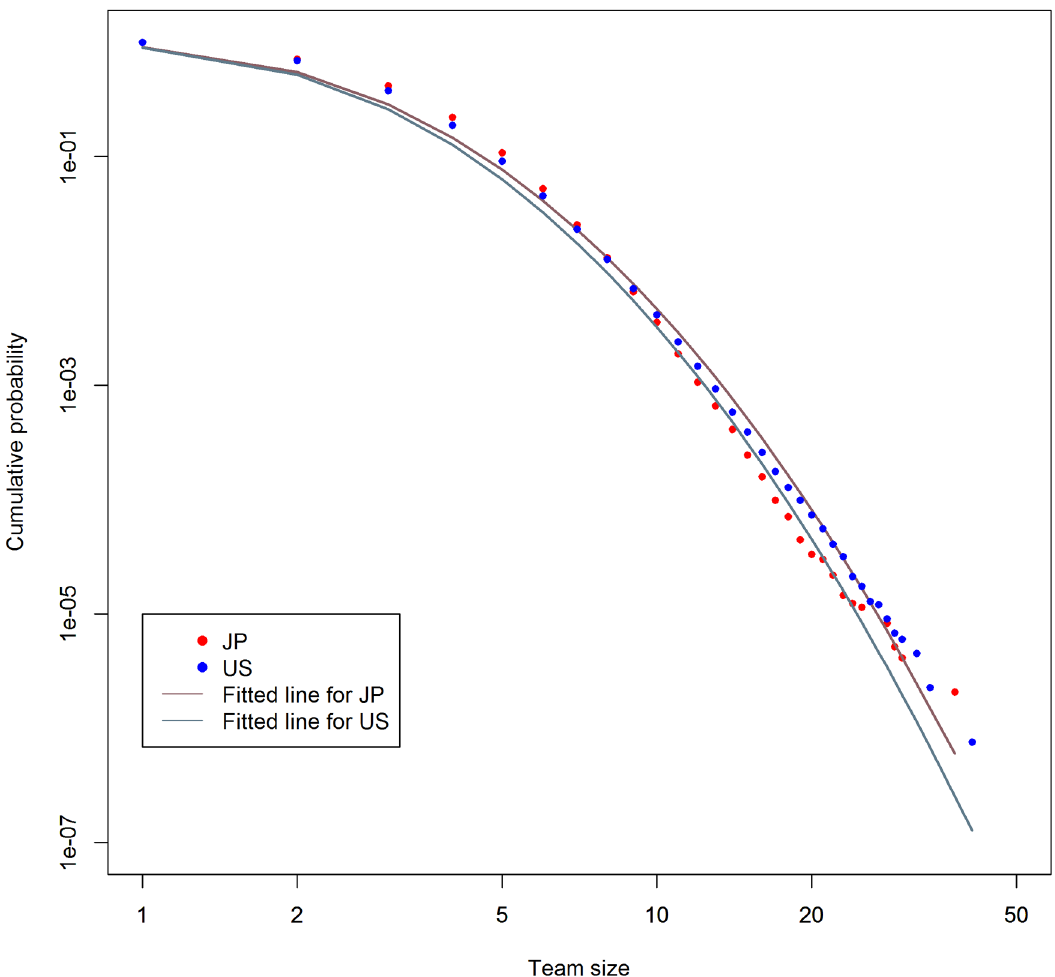
Fig 1. Cumulative probability distribution of team size. Horizontal axis shows team size. Vertical axis shows cumulative probability. Lines are fitted to log- normal distributions.